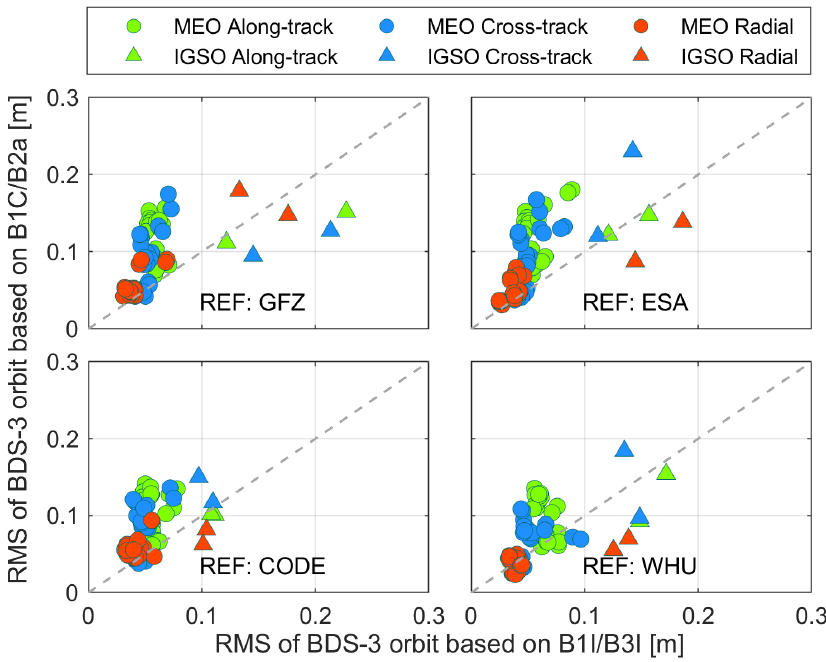
Figure 10. RMS of BDS-3 ISU orbits based on B1I/B3I and B1C/B2a compared with different MGEX ACs in the along-track (A), cross-track (C), and radial (R) directions, respectively.